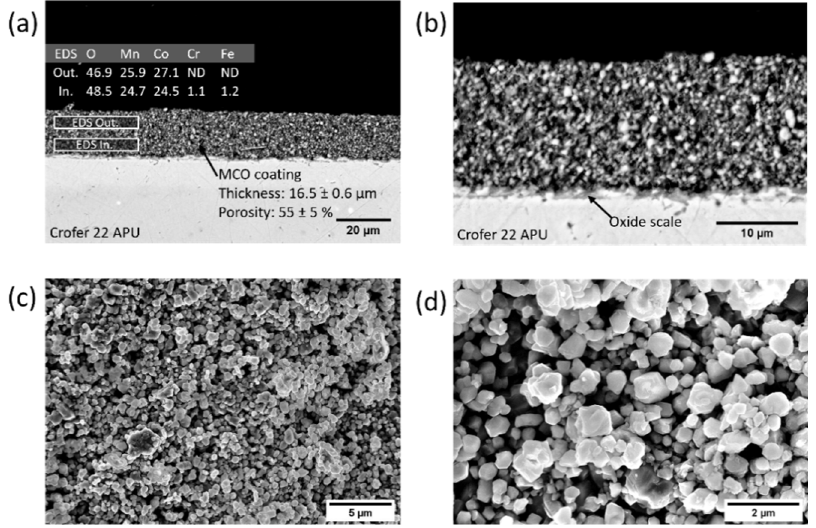
Figure 1. SEM images of 20s_Ox sample at different magnifications: ( a , b ) backscattered electron images and EDX analysis of the cross section; ( c , d ) secondary electron images of the top view.